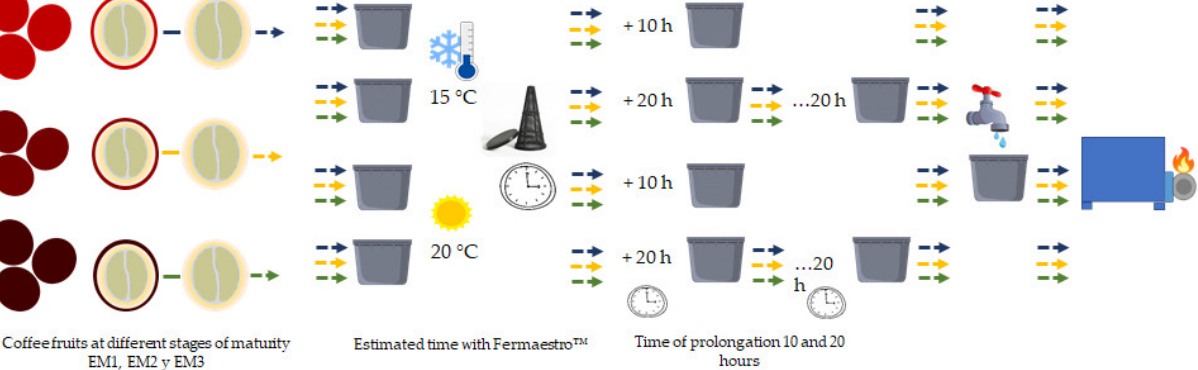
Figure 1. Methodology of prolonged fermentation